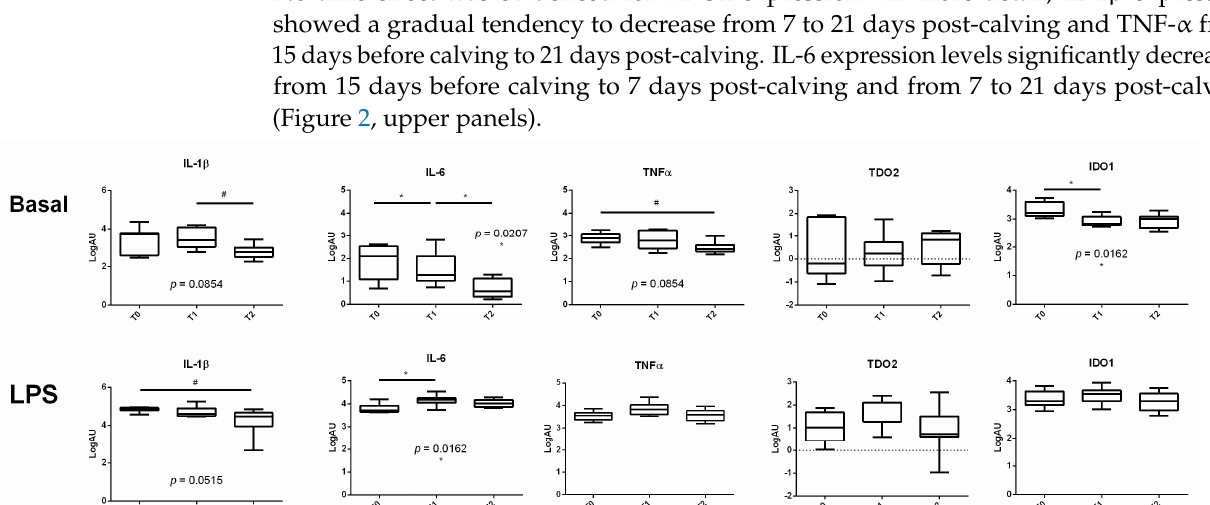
Figure 3. Metabolic and production parameters in healthy and diseased cows. Plasma BHBA and glucose were quantified at 5 DIM (days in milk). Effective milk production was calculated at the end of lactation of each animal. Values are me- dians, Q1 and Q3. # p < 0.1, * p < 0.05. The comparison between healthy and diseased cows highlighted that healthy ani- mals expressed lower levels of proinflammatory cytokines under basal conditions (TNF- α at 15 days before calving and IL-6 at 21 days post-calving; p = 0.0436 and p = 0.0631, respectively; Figure 4, upper panels) and showed a tendency towards lower cy- tokine expression levels after high doses of LPS (20 μ g/mL) stimulation (TNF- α at T0; p = 0.086; Figure 4, lower panels). On the contrary, diseased animals presented higher ex- pression levels of proinflammatory cytokines under both basal and LPS stimulation conditions (Figure 4). Moreover, PBMCs of diseased cows expressed more TDO2 at 7 days post-calving when compared with healthy animals ( p = 0.0046).